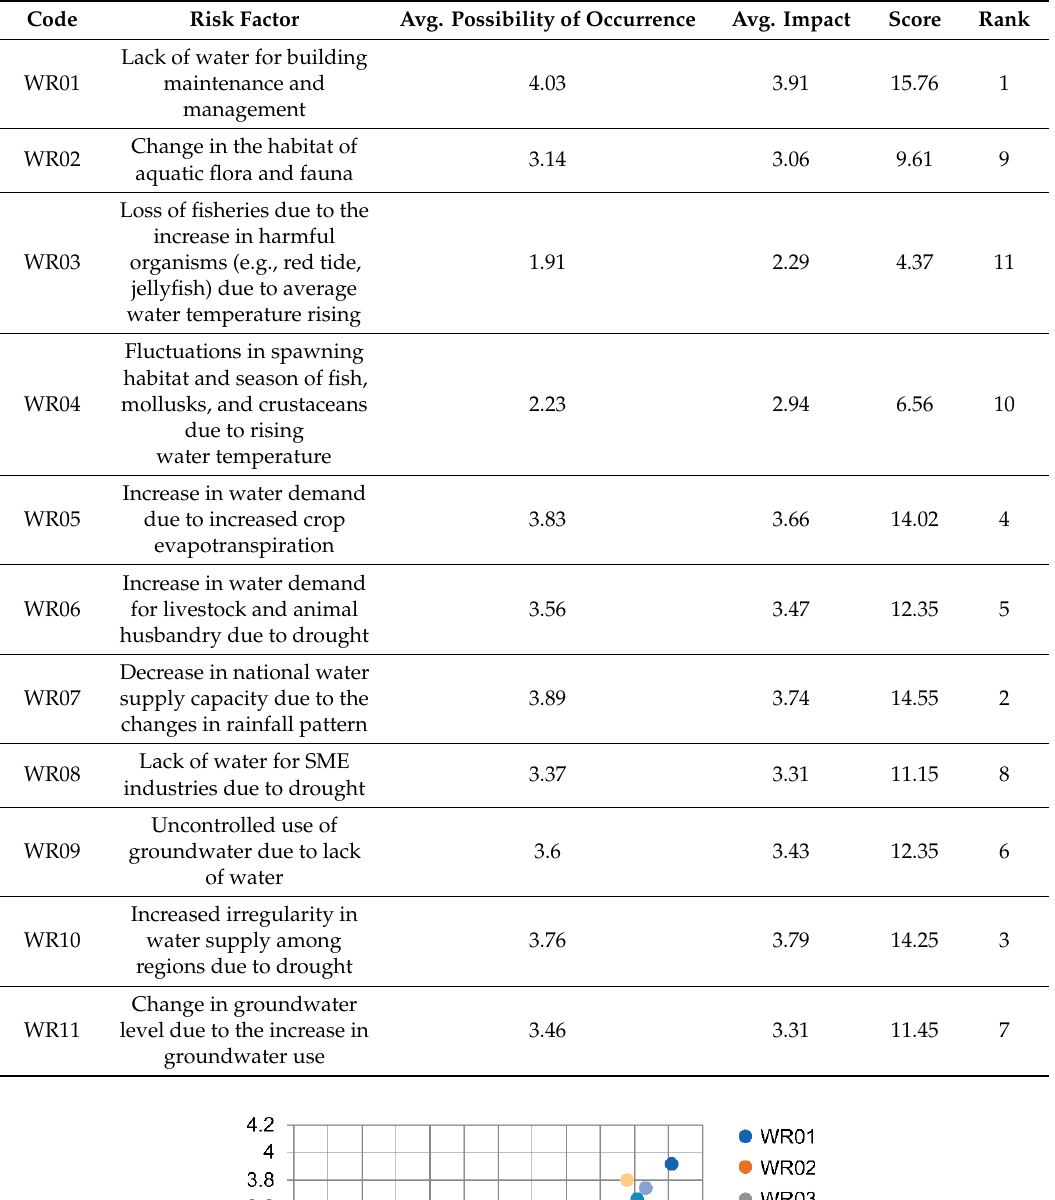
Table 5. Rank of WR (water resources risk / vulnerability) risk factors.